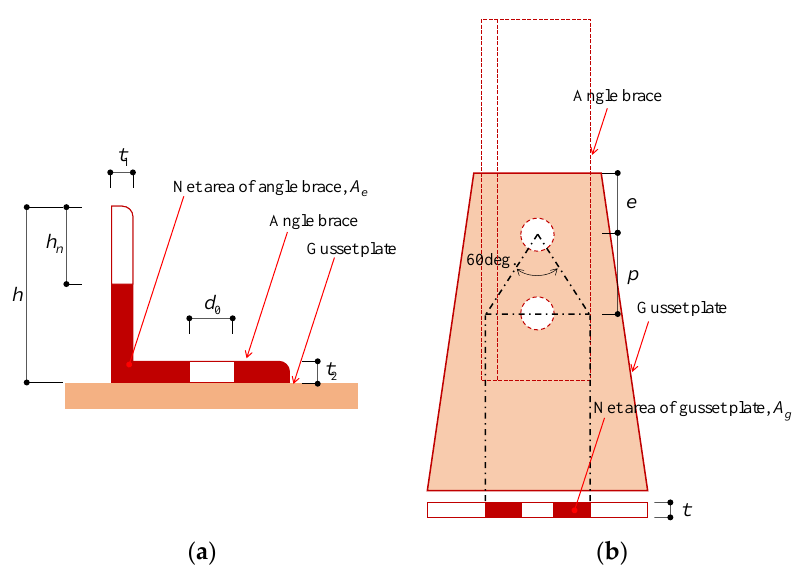
Figure 3. Variables used to calculate tensile strength of brace in net area: ( a ) net area of brace; ( b ) net area of gusset plate.